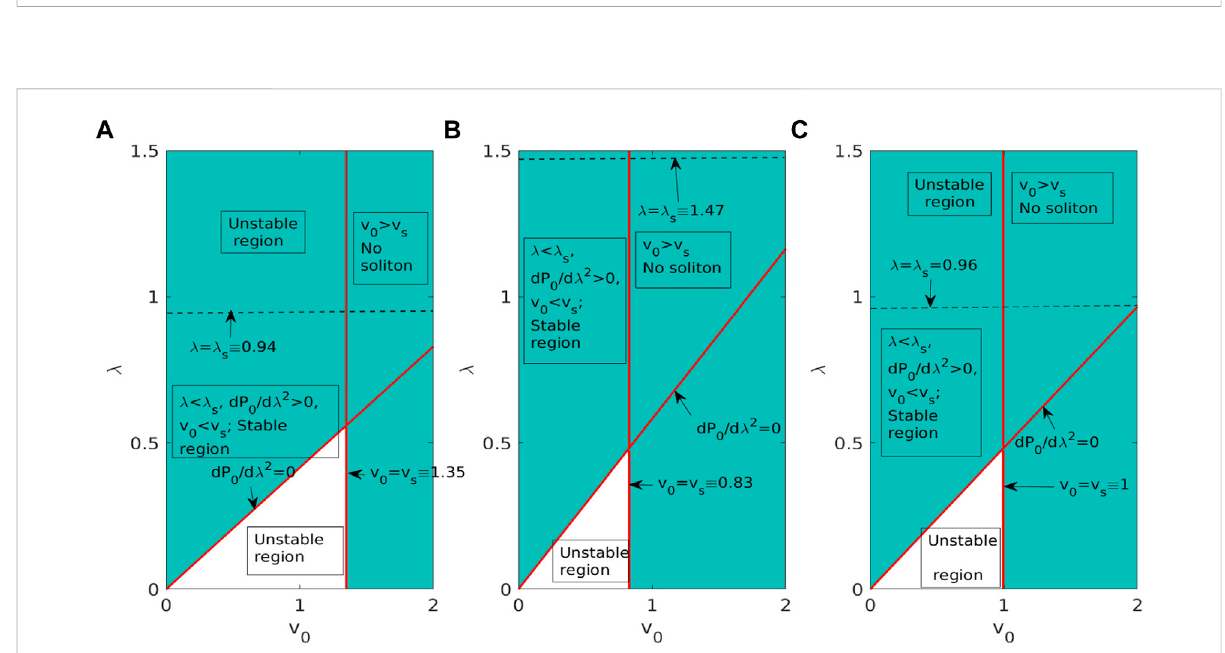
FIGURE 4 The stable and unstable regions as well as the existence domains of EM solitons are shown in the ( v 0 , λ )-plane for diferent values of the parameters: (A)